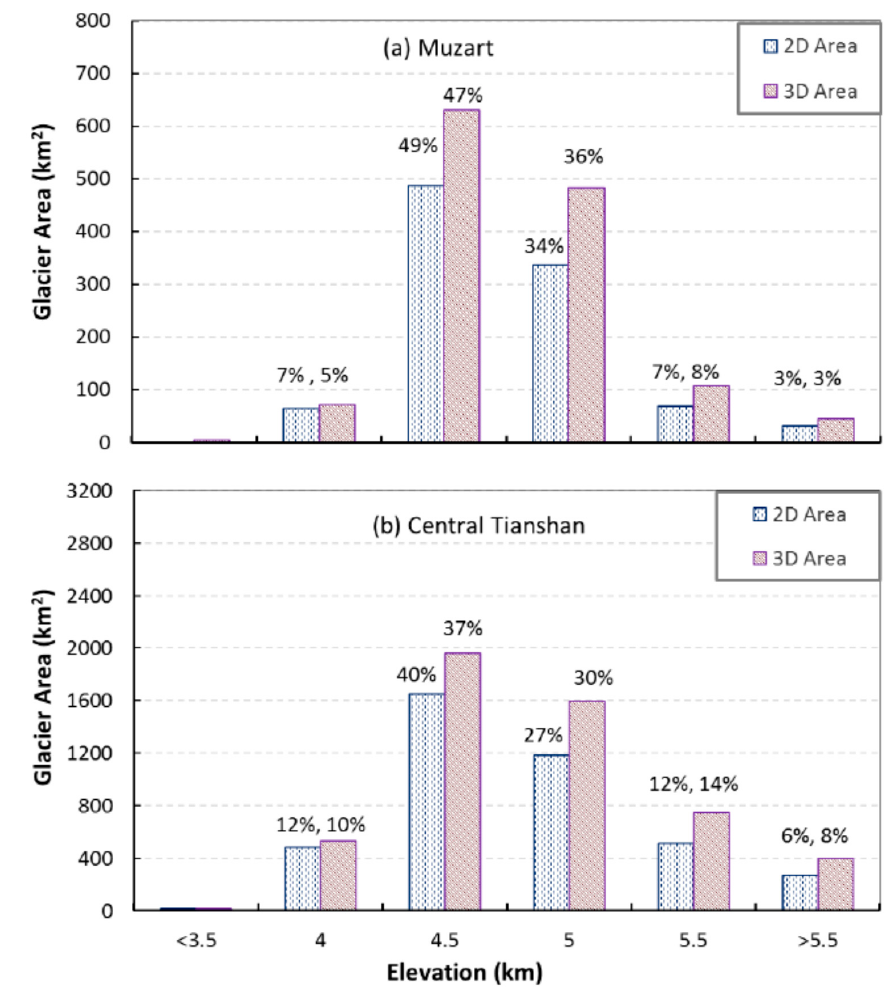
Figure 7. Histogram of Glacier 2D and 3D areas within different elevation bands in 2007 in the Muzart Glacier catchment ( a ) and Central Tianshan ( b ). The numbers above the columns are the frequency percentages of glacier areas in each elevation bands against the total 2D and 3D areas, respectively.